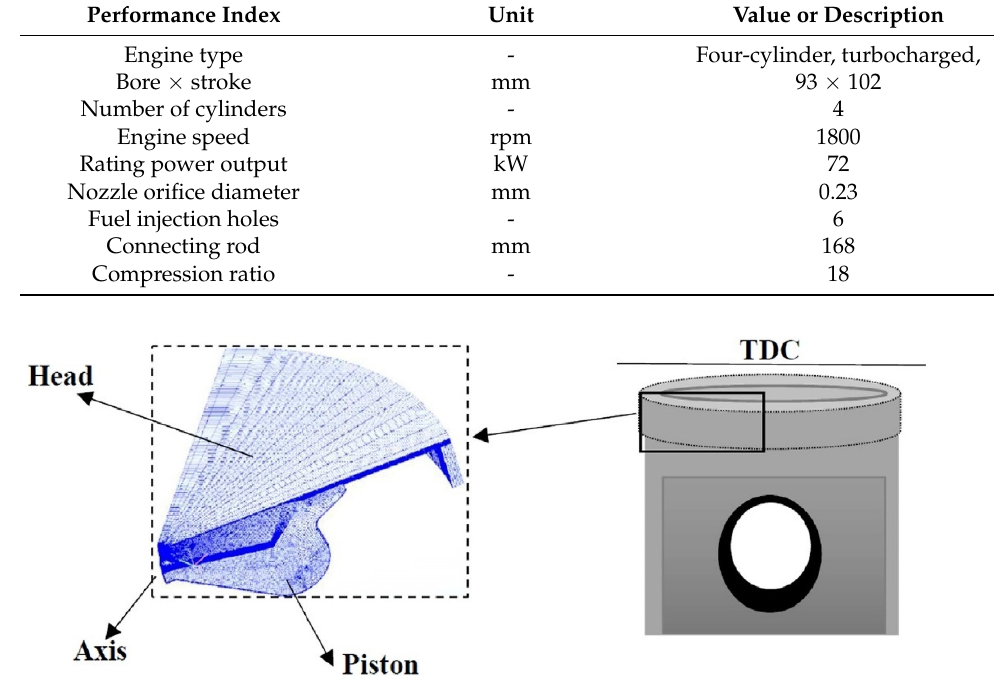
Figure 2. Piston scheme and designed grid of a part piston bowl at TDC position [36].